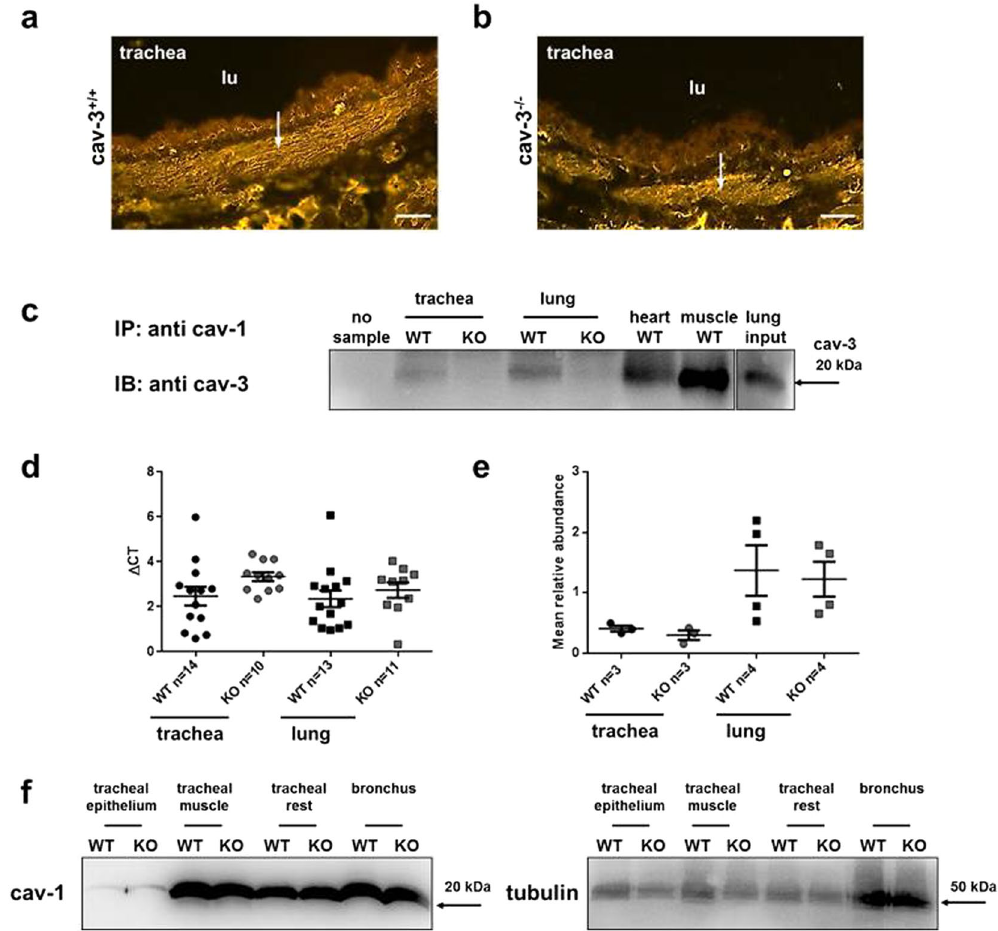
Figure 3. Cav-1 expression in cav-3 + / + (WT) and cav-3 − / − (KO) mice. ( a , b ) Tracheal SMC are cav-1- immunoreactive (arrow) in both mouse strains. Bar = 50 µ m. ( c ) Immunoprecipitates (IP) with cav-1 are immunoblotted (IB) for cav-3. Positive Co-IP controls include heart and skeletal muscle from cav-3 + / + mice. Lung input as intact protein lysate from cav-3 + / + mice is blotted and the expression level of cav-3 protein is observed with longer exposure time. The negative control of Co-IP includes beads and antibody in the absence of lysate (no sample). ( d ) Real-time PCR for cav-1 in cav-3 + / + and cav-3 − / − mice trachea and lung homogenates, relative expression is presented as Δ CT compared to β -actin. Lower Δ CT reflects higher expression. Cav-1 was significantly different in tracheal muscle of cav-3 − / − and cav-3 + / + mice. ( e ) Densitometry from cav-1 Western blots, to allow distribution of cav-1 protein compared to β -tubulin to be compared in cav-3 + / + and cav-3 − / − mouse trachea and lung. Bars represent SEM. Values are means from separate experiments (n). Each individual experiment was analyzed by the Mann-Whitney U-test. * p ≤ 0.05. ( f ) Cav-1 staining is strong in tracheal muscle, bronchus and trachea without epithelium and smooth muscle (tracheal rest), while being faint in tracheal epithelium. Tubulin-immunolabelling is observed in the preparations from cav-3 + / + and cav-3 − / −